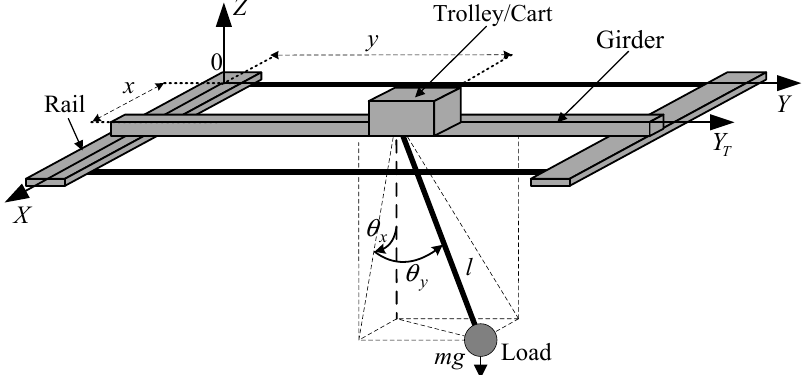
Figure 1. Schematic structure for a 3D overhead crane [53].